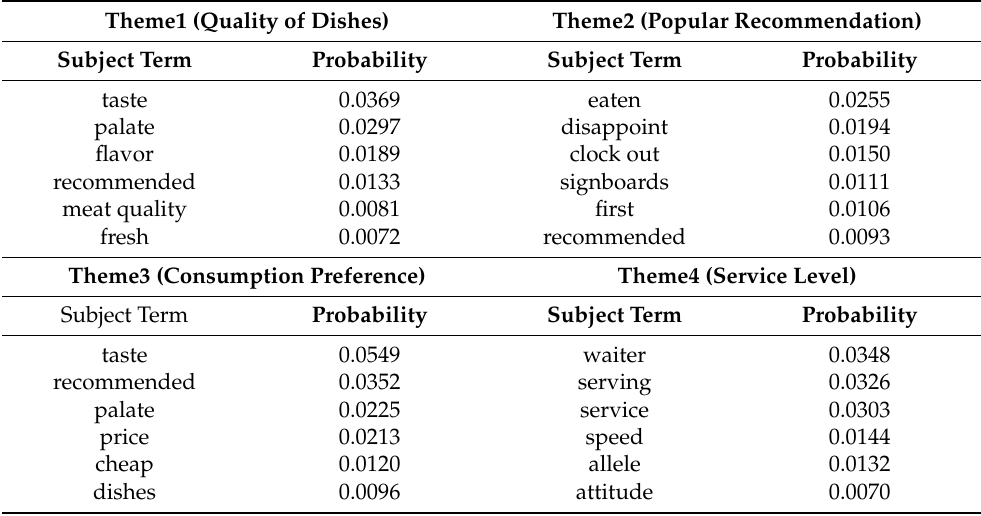
Table 8. Fourpre-COVID-19 topic models based on Latent Dirichlet Allocation (LDA) Algorithm.